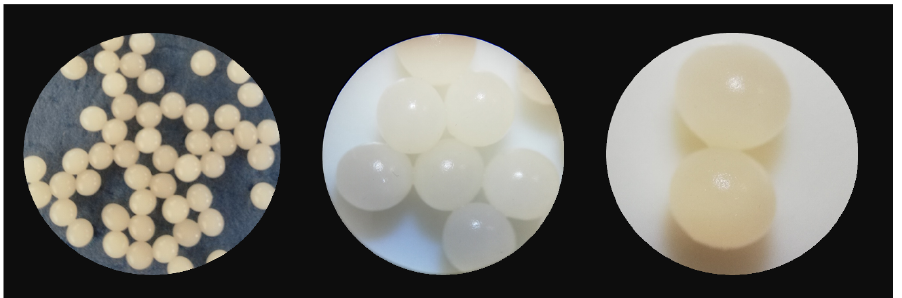
Figure 3. Saccharomyces cerevisiae /calcium alginate